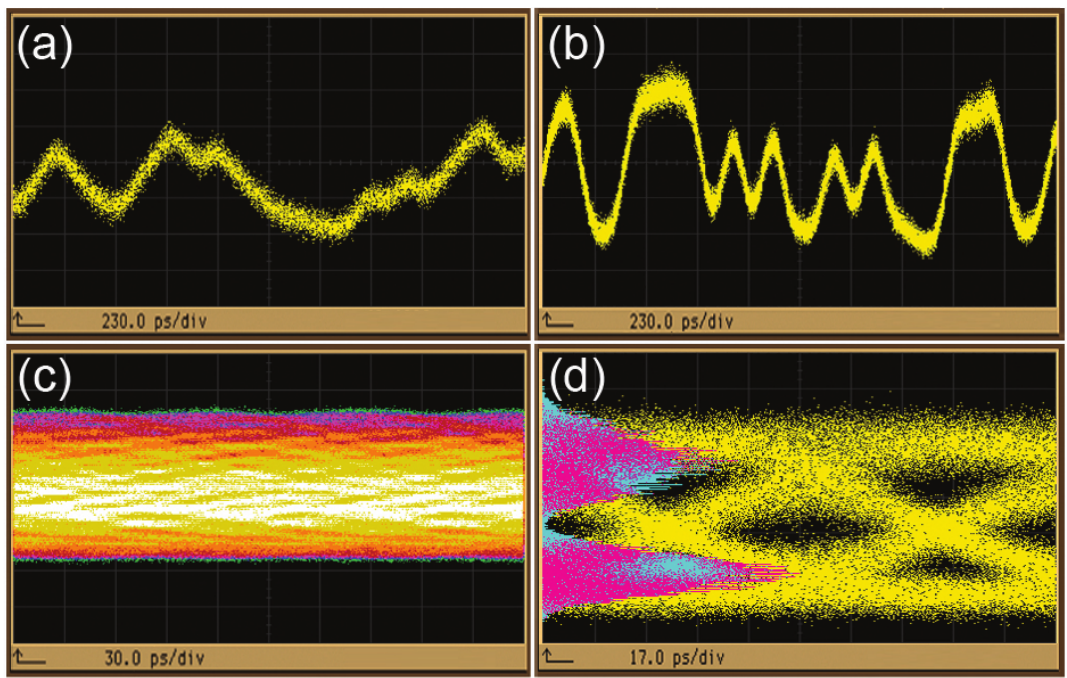
Figure 18. Top: Encoded pulse waveforms of ( a ) RSOA output and ( b ) BFL output for detuning ∆ λ = − 0.05 nm at 11 Gb/s. Bottom: Corresponding eye diagrams ( c , d ). Vertical scale: ( a ) 5 mV/div, ( b ) 15 mV/div, ( c ) 15 mV/div and ( d ) 13